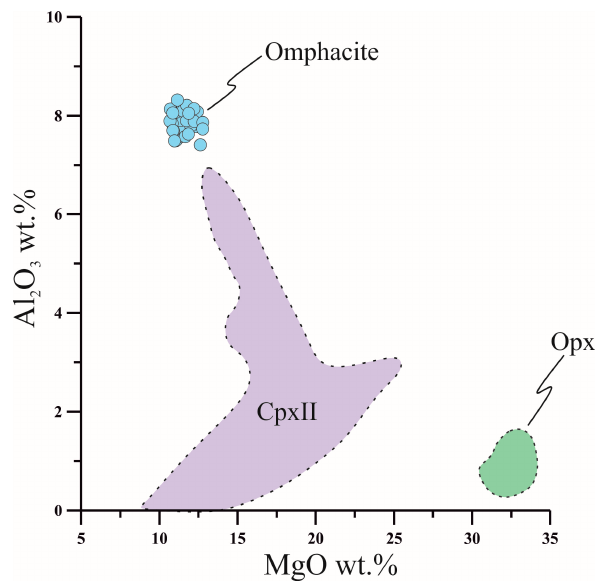
Figure 4. Al 2 O 3 vs. MgO (wt%) in primary clinopyroxene (omphacite = CpxI), secondary clinopyroxene (CpxII) and secondary orthopyroxene (Opx).